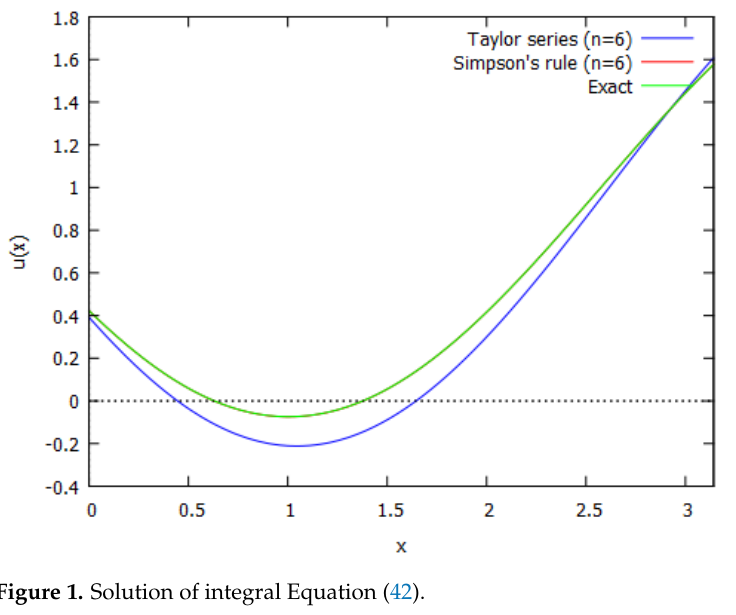
Figure 1. Solution of integral Equation